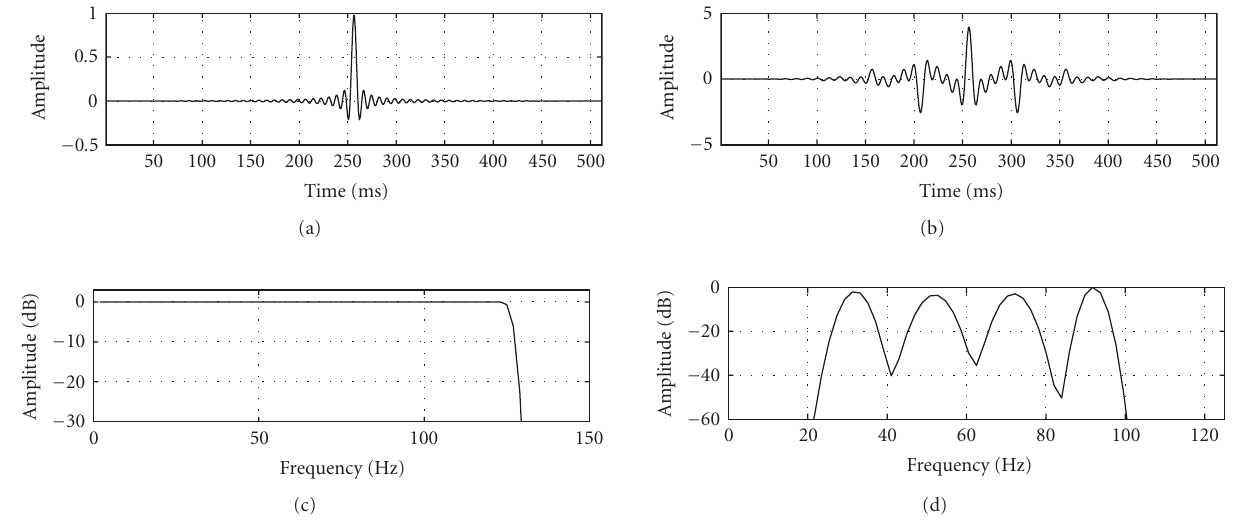
Figure 4: ULF sources: waveforms and spectrums. The first signal (a) and (c), denoted as ULF-1, is a flat spectrum transient. The second signal (b) and (d), denoted as ULF-2, is a broadband comb-type (“4 hills” spectrum) transient.